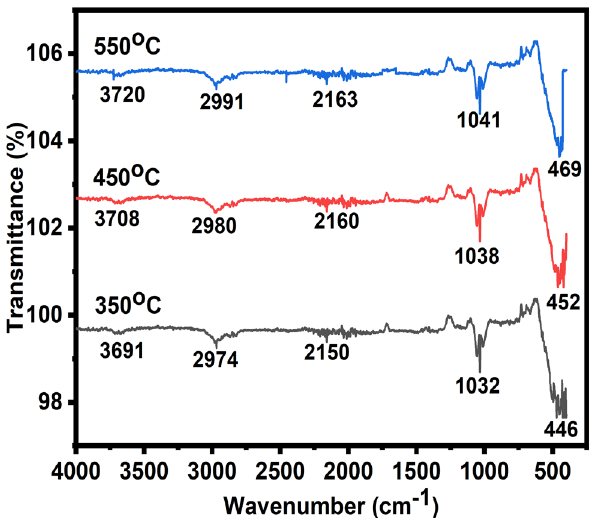
Figure 5: FTIR spectra of CuO samples calcinated at 350, 450, and 550°C.